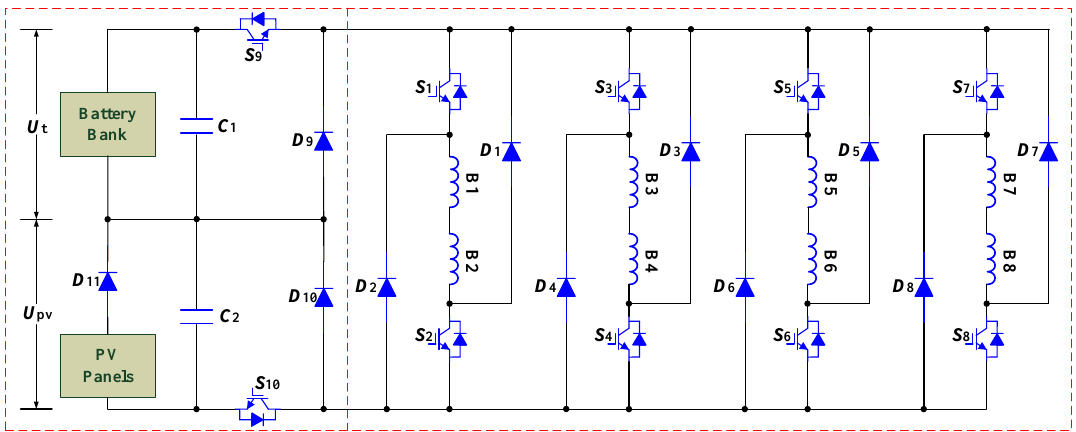
Figure 1. The multiport driving topology of the switched reluctance motor (SRM).